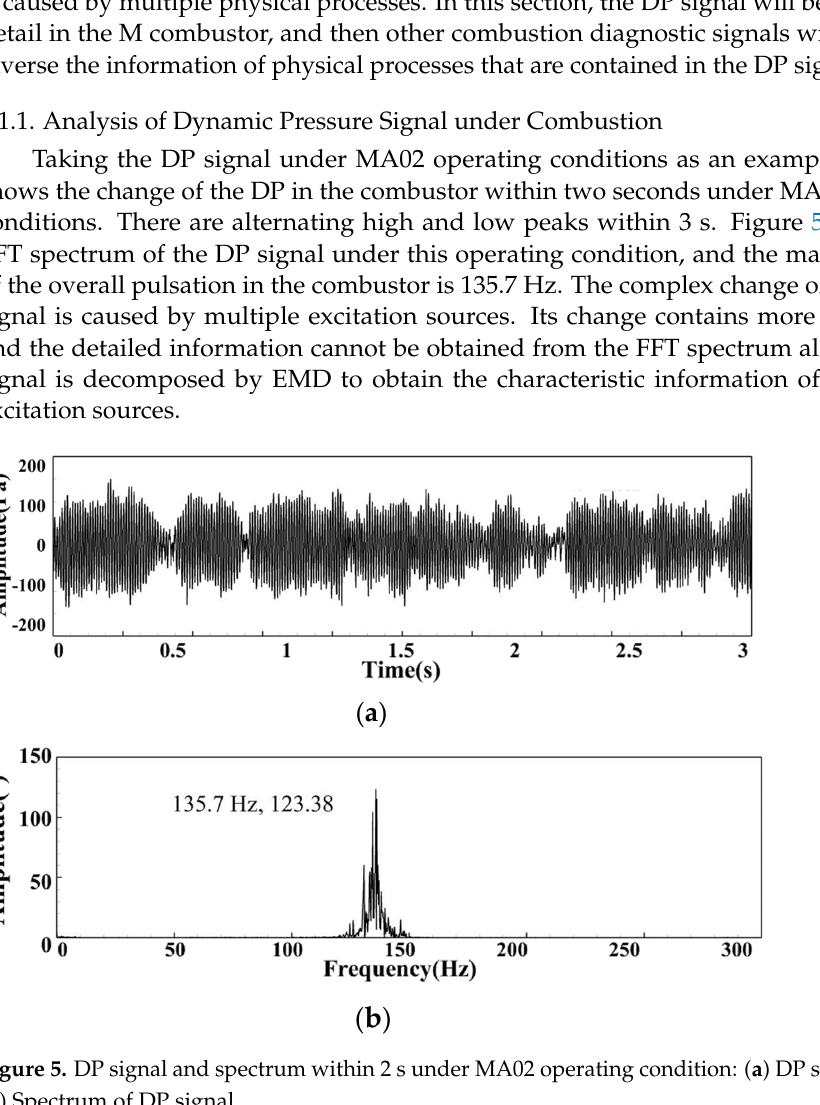
Figure 4. Analysis of the flame image: ( a ) The original image; ( b ) the image after median filter; ( c )